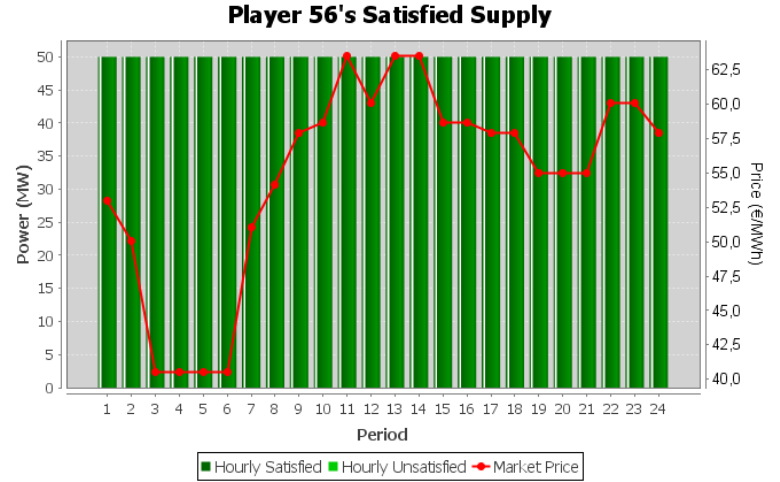
Figure 10. Player 56’s satisfied supply.